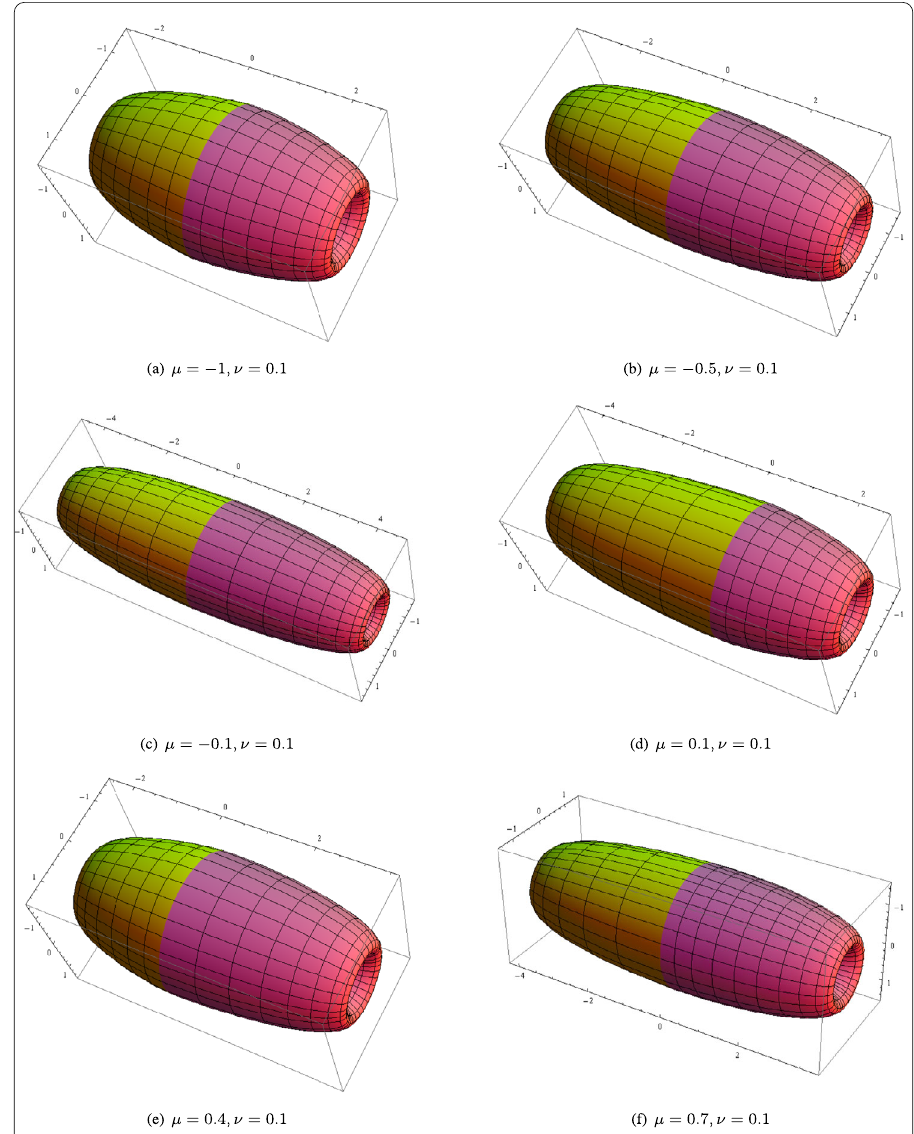
Figure 23 GBT-Bézier rotating capsule surfaces with different shape parameters